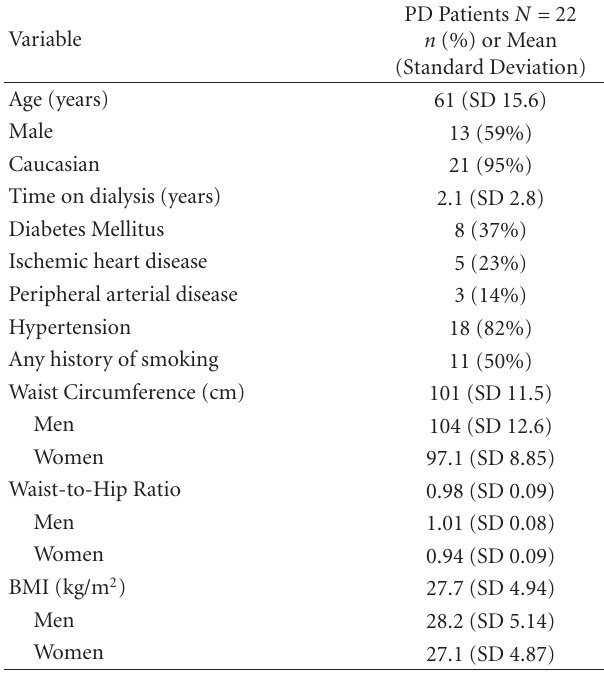
Table 1: Baseline characteristics of the 22 peritoneal dialysis patients